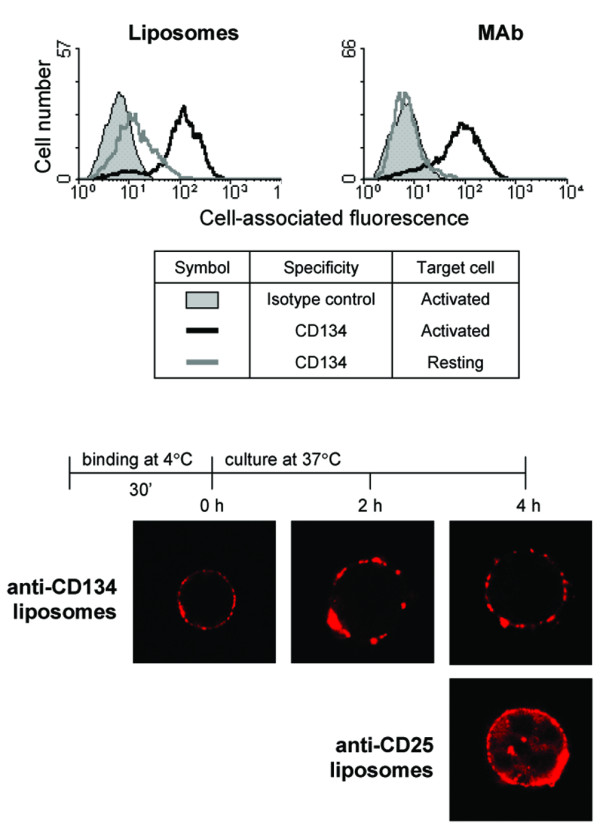
Anti-CD134-mediated targeting does not lead to liposome internalization by activated CD4+ T cells in vitro. A2b T cells were cultured with antigen-presenting cells and Con A to induce CD134 expression; CD25 is expressed constitutively on these cells. (a) Viable T cells were incubated with isotype control liposomes (filled histogram) or with anti-CD134 liposomes (black line). As a control, the binding of anti-CD134 liposomes or anti-CD134 monoclonal antibodies to resting T cells was assessed (gray lines). Cell-associated fluorescence was analyzed by flow cytometry, with live cells gated on the basis of forward scatter (FSC) and side scatter (SSC) profiles. One representative experiment of three is shown. (b) Viable T cells were incubated for 30 min with anti-CD134 liposomes on ice. After the removal of non-bound liposomes by washing, cells were cultured subsequently at 37°C. Samples were taken at the indicated time points and analyzed for the cellular localization of the liposomal fluorescence with the use of confocal microscopy. A representative cell from each time point is shown. As a positive control for cellular internalization of liposomes, cells incubated with anti-CD25 liposomes are shown. One of two experiments, yielding similar results, is shown.